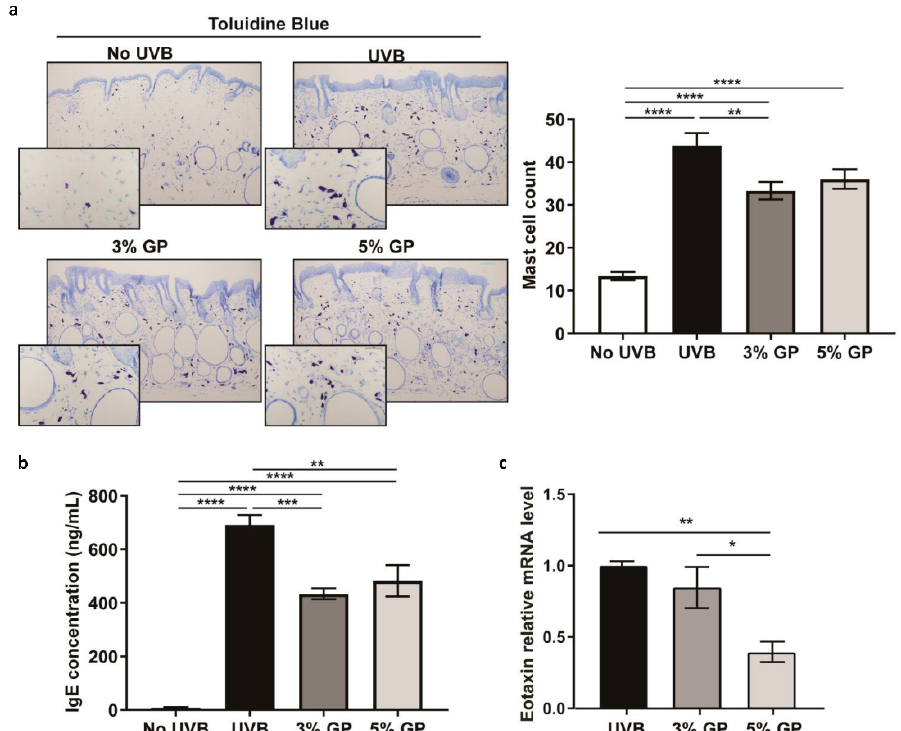
Figure 5. Dietary GP consumption reduces dermal mast cell presence, serum IgE and Eotaxin expression. ( a ) Mast cells were identified by toluidine blue staining in the dermal region of the dorsal skin of the no UVB groups and the involved skin directly adjacent to tumors of all groups treated with UVB. Images are at 10 × magnification, with inset at 40 × magnification to show the appearance of mast cells. Mast cell number was quantified from five images at 20 × magnification per animal using ImageJ program and averaged. The data represent the mean ± SEM of all animals per group. ( b ) Total serum IgE concentration was determined by ELISA. ( c ) RT-qPCR analysis of Eotaxin expression in papules. Data are presented as the mean ± SEM of three biological pools of three animals per group (n = 9) in technical triplicate. A one-way ANOVA with Tukey’s multiple comparison test was performed (* p < 0.05, ** p < 0.01, *** p < 0.001, **** p < 0.0001).